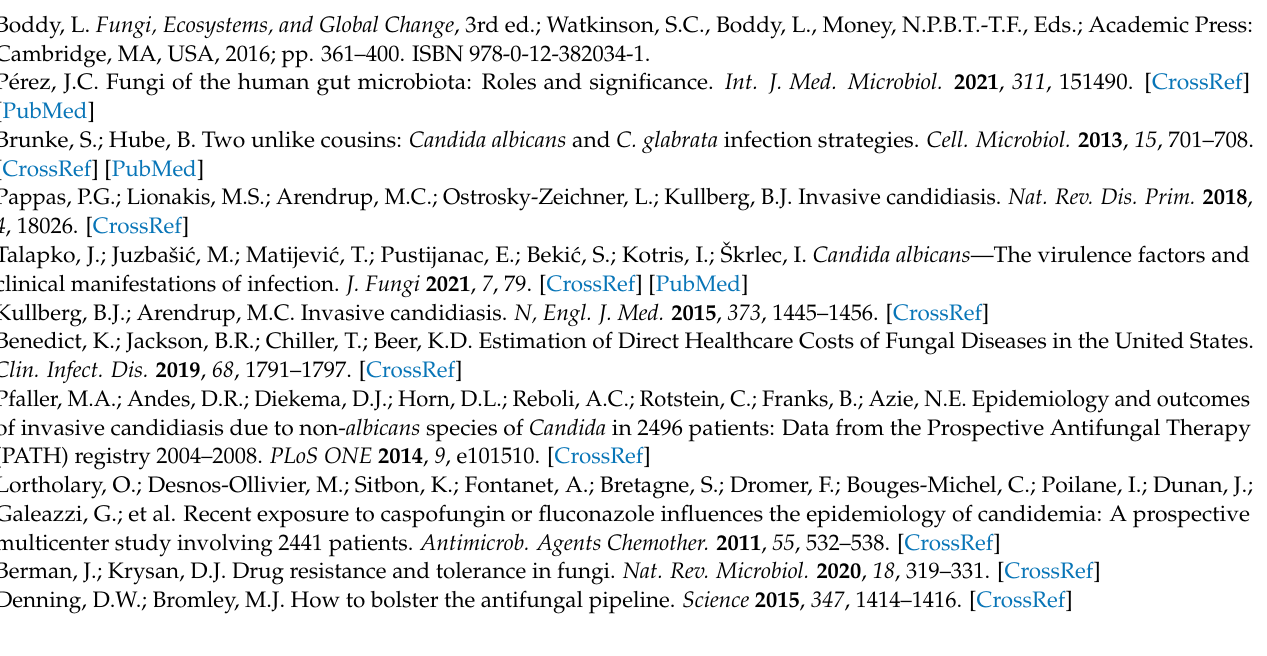
experiment. Figure S4: 13 C NMR spectrum of R4 subfraction with the main chemical shifts of 1. Figure S5: HRMS-ESI of the compound 1. Figure S6: 13 C NMR spectrum of R4 subfraction with the main chemical shifts of 2. Figure S7: HRMS-ESI of the compound 2. Table S1: Concentration range tested for MIC and MFC